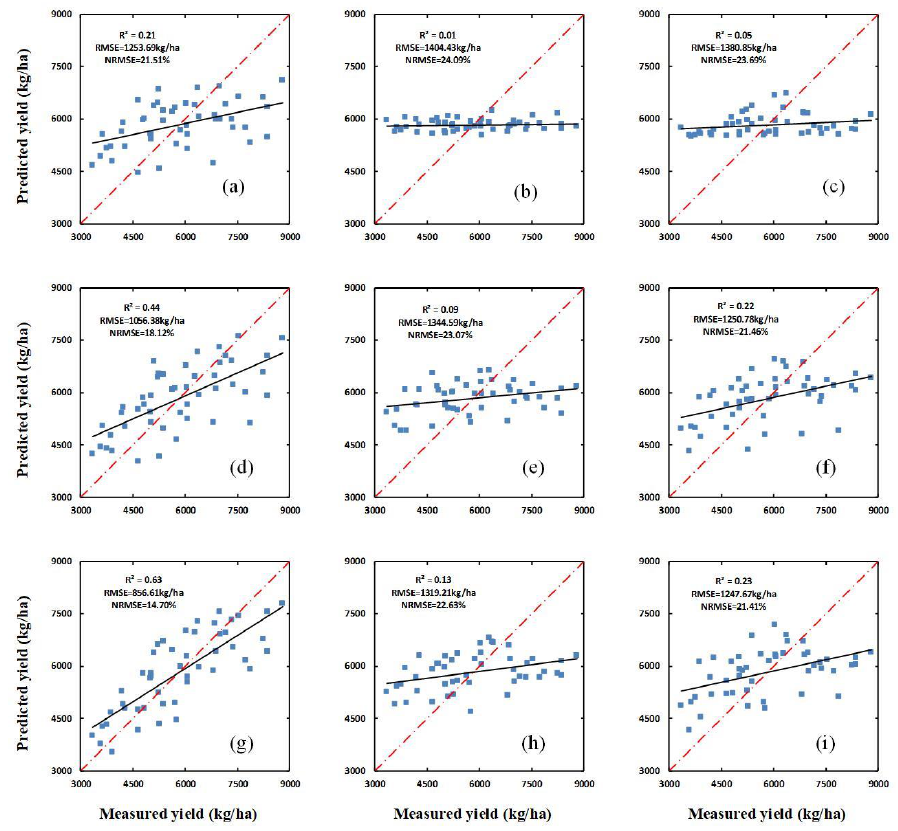
Figure 4. The relationships between the ground-measured winter-wheat yield and the yield predicted using the PBI, H, and H CSM in different growth stages of winter wheat. ( a ), ( b ), and ( c ) show the relationships between the measured yield and the yield predicted using the PBI, H, and H CSM at the jointing stage, respectively; ( d ), ( e ), and ( f ) show the same as ( a ), ( b ), and ( c ) for the flagging stage; and ( g ), ( h ), and ( i ) show the same as ( a ), ( b ), and ( c ) for the flowering stage. The optimal vegetation indices—namely, the PBI—was combined with H and H CSM for regression analysis. The results, given in Table 3 and Figure 5, show that for all three growth stages the yield predictions obtained using a combination of the PBI and H and a combination of the PBI and H CSM are superior to the predictions obtained using the PBI, H, and H CSM individually (see Table 2). For the yield predictions obtained using a combination of the PBI and H, and a combination of the PBI and H CSM , the R 2 values increase, and the RMSE and NRMSE decrease. For the yield predictions obtained using a combination of the PBI and H, the R 2 values are 0.23, 0.45, and 0.66 in the jointing, flagging, and flowering stages, respectively; the RMSE values are 1243.39, 1052.30, and 819.66 kg/ha, respectively; and the NRMSE values are 21.33%, 18.05%, and 14.06%, respectively. Meanwhile, for the yield predictions obtained using a combination of the PBI and H CSM , the R 2 values are 0.23, 0.48, and 0.69 in the jointing, flagging, and flowering stages, respectively; the RMSE values are 1237.70, 1023.87, and 781.51 kg/ha, respectively; and the NRMSE values are 21.23%, 17.57%, and 13.41%, respectively. Table 3. Results of yield estimation obtained using a combination of the PBI and H, and a combination of the PBI and H CSM , for different growth stages.